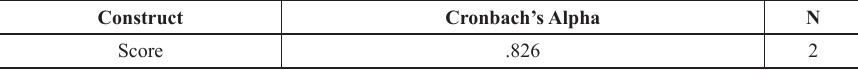
Table 3. Reliability statistics of the Total Score and Lexical Aspect